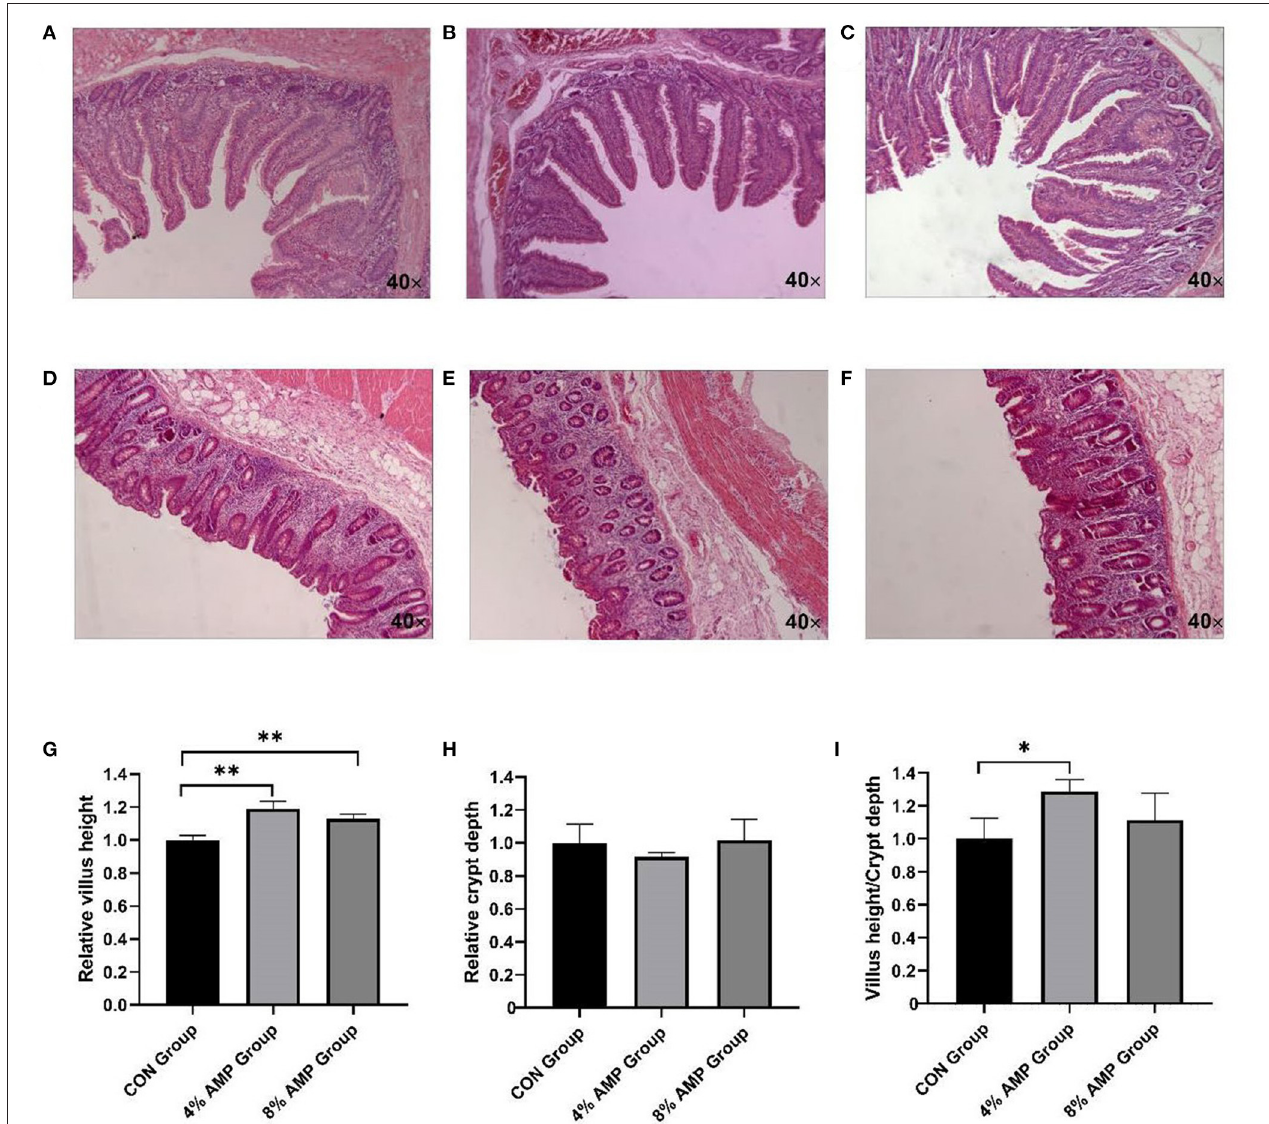
FIGURE 1 | Effect of dietary AMP supplementation on the intestinal morphology of pigs. (A) Jejunal section of CON group pigs; (B) jejunal section of 4% AMP group pigs; (C) jejunal section of 8% AMP group pigs; (D) cecal section of CON group pigs; (E) cecal section of 4% AMP group pigs; (F) cecal section of 8% AMP group pigs; (G) jejunal relative villus length; (H) jejunal relative crypt depth; (I) villus height/crypt depth ratio (VCR). All data are expressed as the relative average ± SD, n = 6. * P < 0.05, ** P <